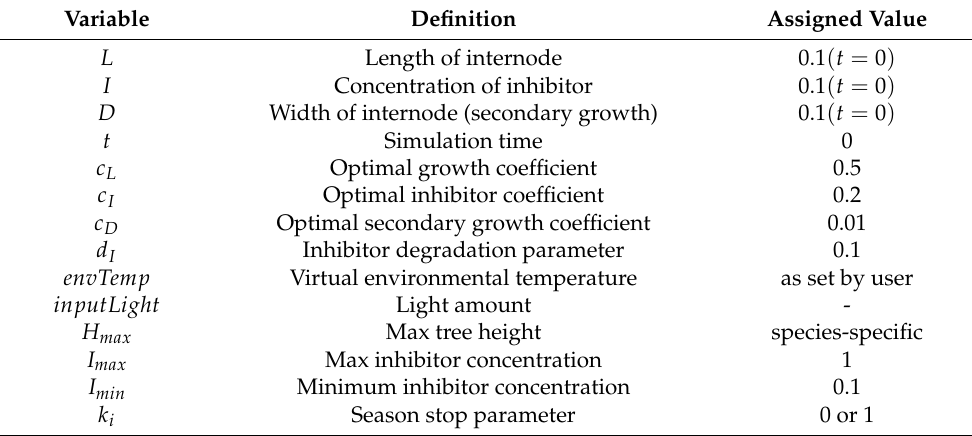
Table 1. Variables involved in tree growth ODEs